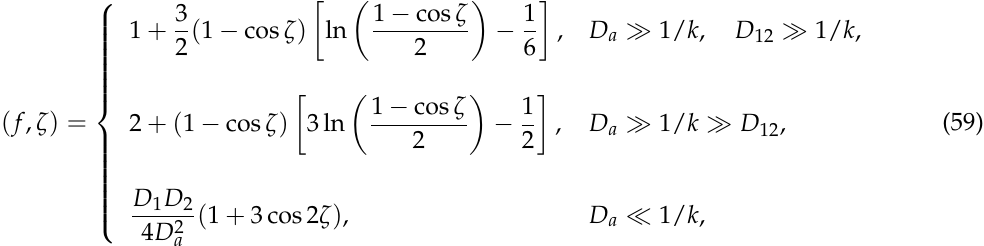
Figure 7b. Sensitivity of a subsystem of a pair of atomic sensors is discussed in, e.g., Ref.